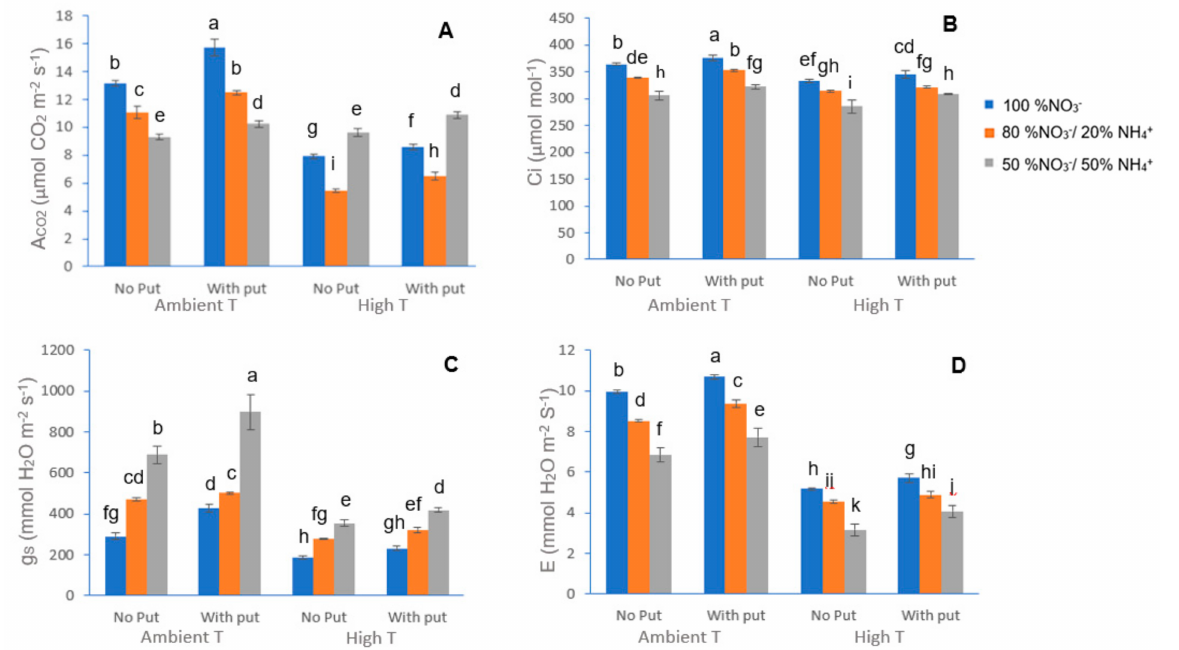
Figure 1. Effect of heat stress, different NO 3 − /NH 4+ ratio and absence or putrescine sprayed at 2.5 mM on net photosyn- thetic rate (A CO2 ) ( A ), intercellular CO 2 concentration (Ci) ( B ), stomatal conductance (g s ) ( C ) and evapotranspiration (E) ( D ) in leaves of cauliflower. n = 5, ± S.E. Different letters are significantly different according to Tukey test at p ≤